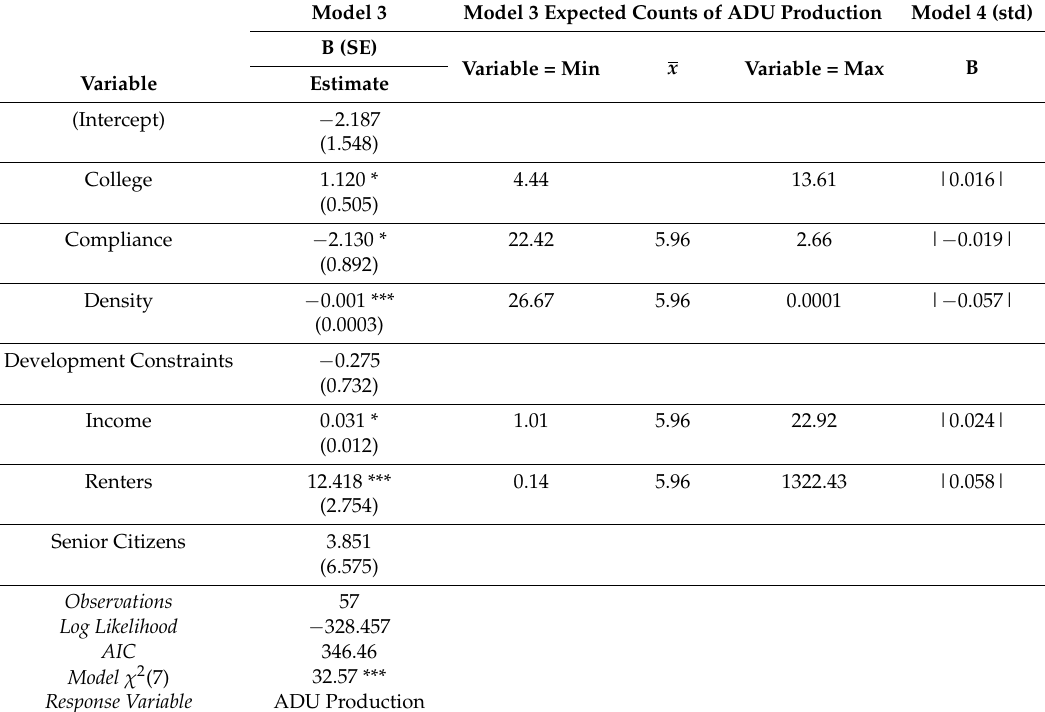
Table 9. The negative binomial regression models. Model 3 contains the full sample and Model 4 (std) contains the standardized coefficients of Model 3. Model 3 indicates that college cities could expect roughly 14 ADUs in contrast to roughly four ADUs for non-college cities. Cities with values that are close to the respective means of compliance, density, median household income, and proportions of renters could respectively expect roughly six ADUs for each variable. Of the five statistically significant variables in Model 4 (std), renters maintained the most influence due to the absolute value of |0.058|. Notes: ADU = accessory dwelling unit, SE = standard error, STD = standardized; * = p < 0.05, *** = p < 0.001.